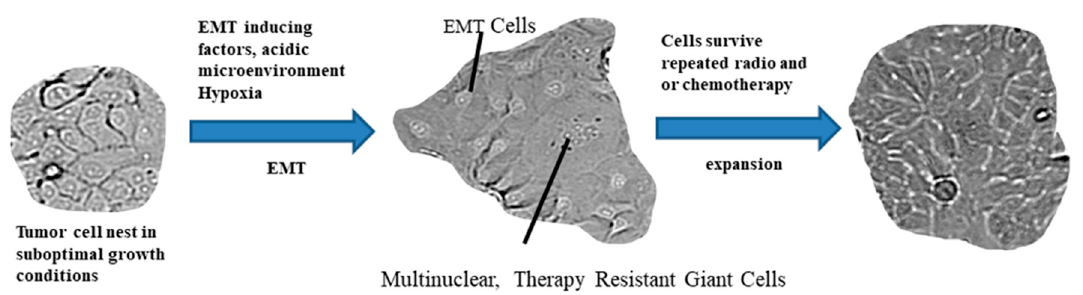
Figure 4. Multinuclear giant cells are therapy surviving intermediates. Hostile environmental conditions and hypoxia, in concert with EMT triggering factors, might induce EMT cells and polyploid giant cancer cells (PGCCs). These cells are also produced by serum-free culture conditions using conditioned media of oral squamous cell carcinoma cells and fibroblasts at pH = 6.7. These giant cells are also frequently the surviving cells of cultured OSCC cell lines during cisplatin or mitomycin C treatments. After the treatment cycles, the giant cells contribute to the expansion of the cell culture of normal epithelial tumor cell nests.